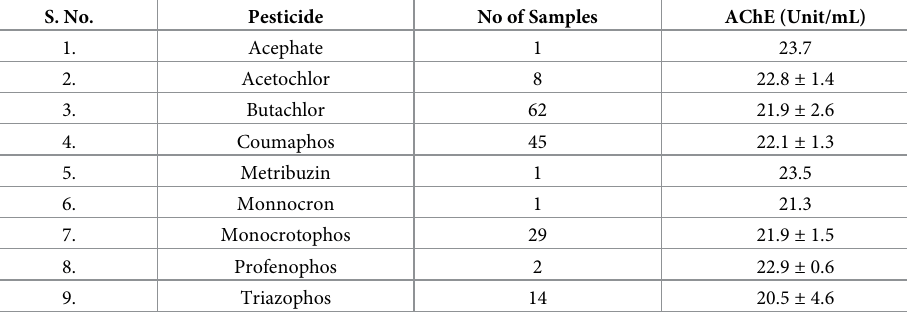
Table 5. AChE levels in comparison with different pesticide exposures. S.